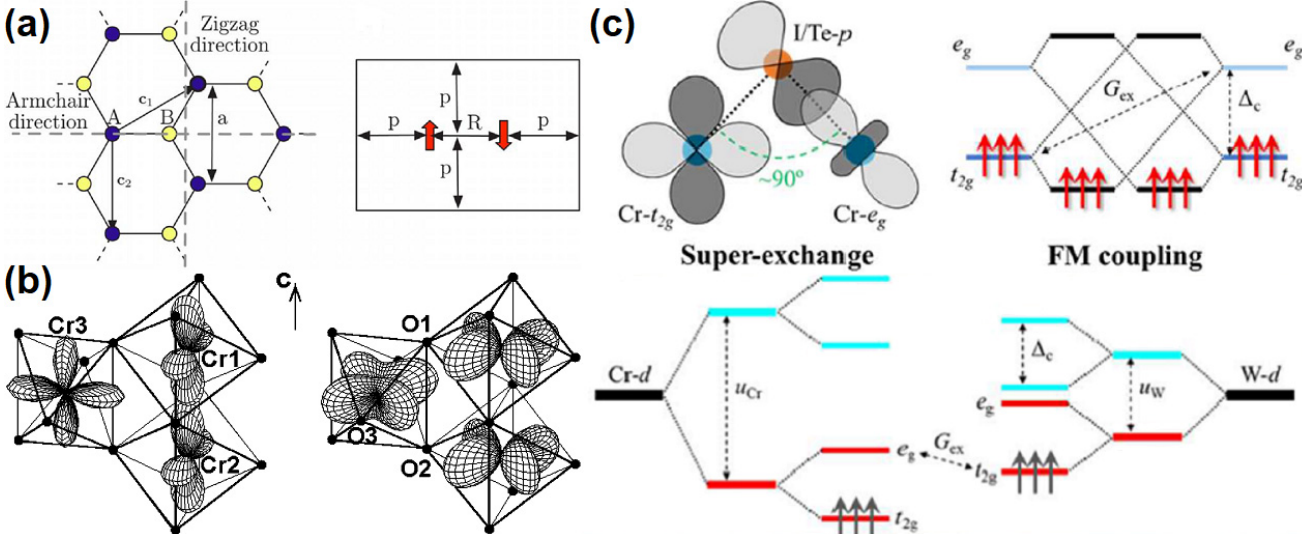
Figure 1. (Color online). ( a ) Graphene honeycomb lattice with the two sublattices, A and B, in dark and light colors, respectively. The lattice unit vectors, c 1 and c 2 , lattice constant a = 2.46 Å, as well as the two most common directions, zigzag and armchair, are displayed (left). Unit–cell setups in the antiferromagnetic configuration with the distance, R, between impurity spins are shown, as well as the padding, p, surrounding them (right). Reused with permission from [35] . ( b ) Angular distribution of ab (left) and ( yz + zx ) (right) electron spin density for the nearest Cr neighbors as determined by LSDA + U . The crystallographic c -axis is indicated. The left panel shows orbitals containing localized spins, and the right panel shows the more dispersive d orbitals forming bands that cross the Fermi level. Reused with permission from [38] . ( c ) Schematic diagrams of the superexchange interaction and ferromagnetic coupling in CrI 3 and CrGeTe 3 monolayers (upper panel). G ex is the virtual exchange gap and Δ c represents the energy gap opened by the crystal field. Red arrows represent the spin-up electrons. Schematic diagrams of orbital evolution and the origin of energy level staggering in Cr and W alloy systems (lower panel). The red and cyan bars represent spin-up and spin-down orbitals, respectively. The u Cr and u W are the exchange splits for the Cr- and W- d orbitals, respectively. The Δ c is the energy gap opened by the crystal field. Reused with permission from [50] .